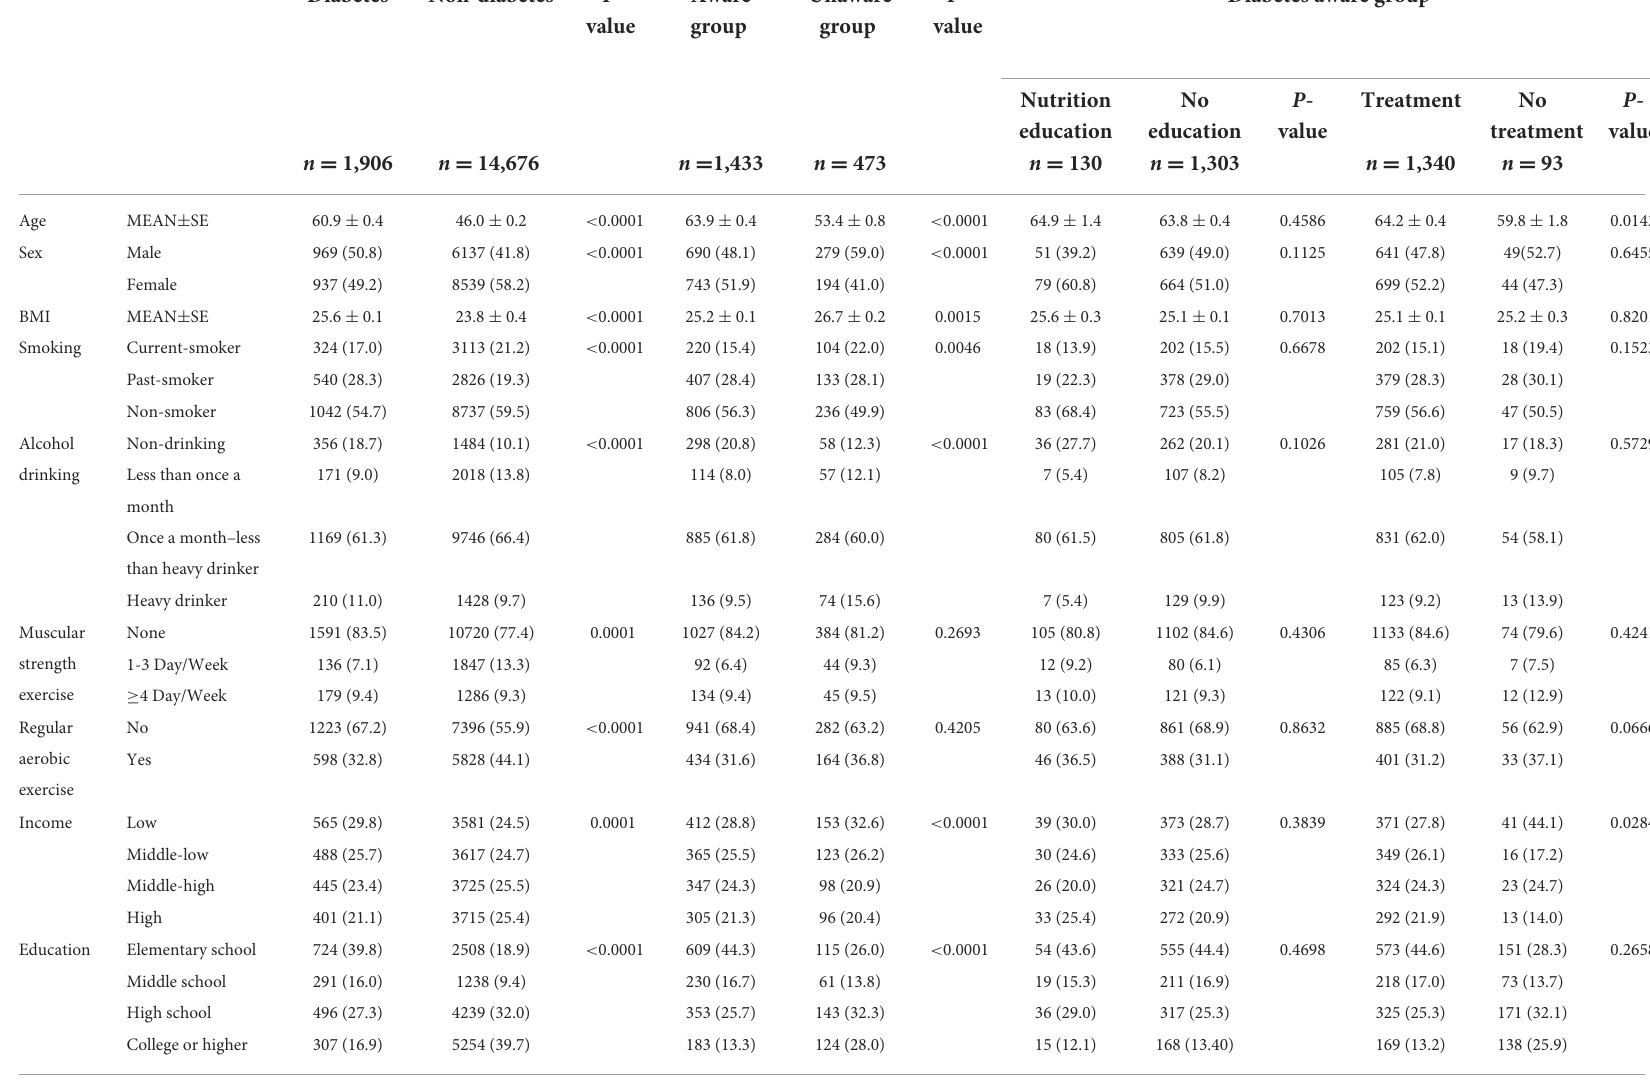
Diabetes Non-diabetes P -